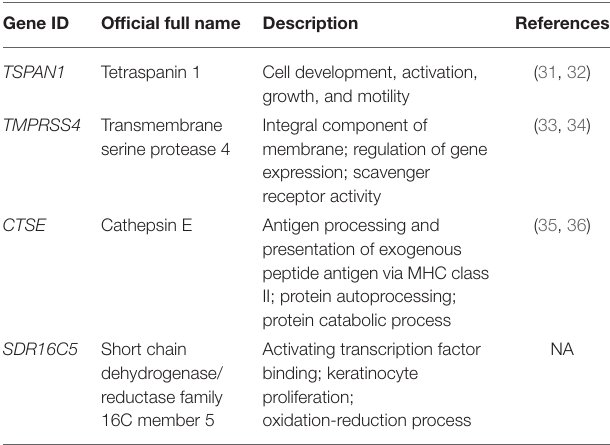
TABLE 2 | Summary of four hub genes identified by weighted gene co-expression network analysis.